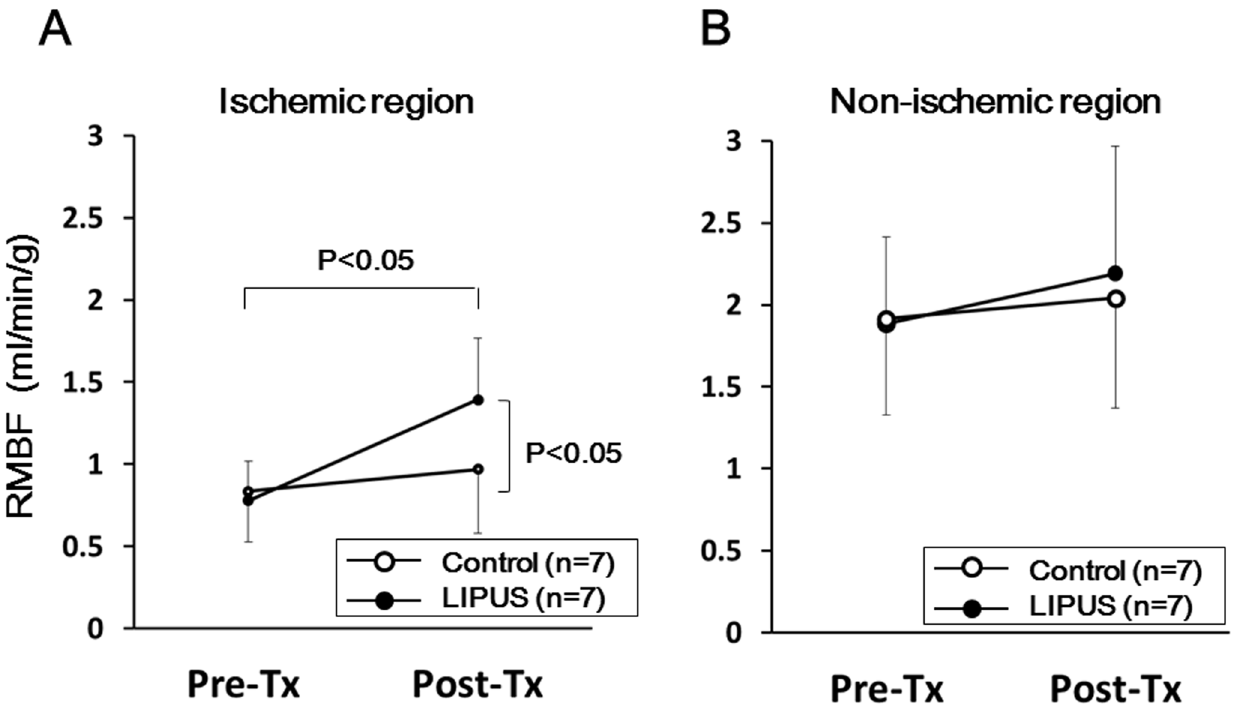
Figure 6. LIPUS therapy improved RMBF in the ischemic region in vivo. LIPUS therapy significantly increased RMBF, assessed by colored microspheres in the lateral wall ( A ), while it was not changed in the both groups in the non-ischemic IVS region ( B ). Results are expressed as mean 6 SEM (n=7 each).